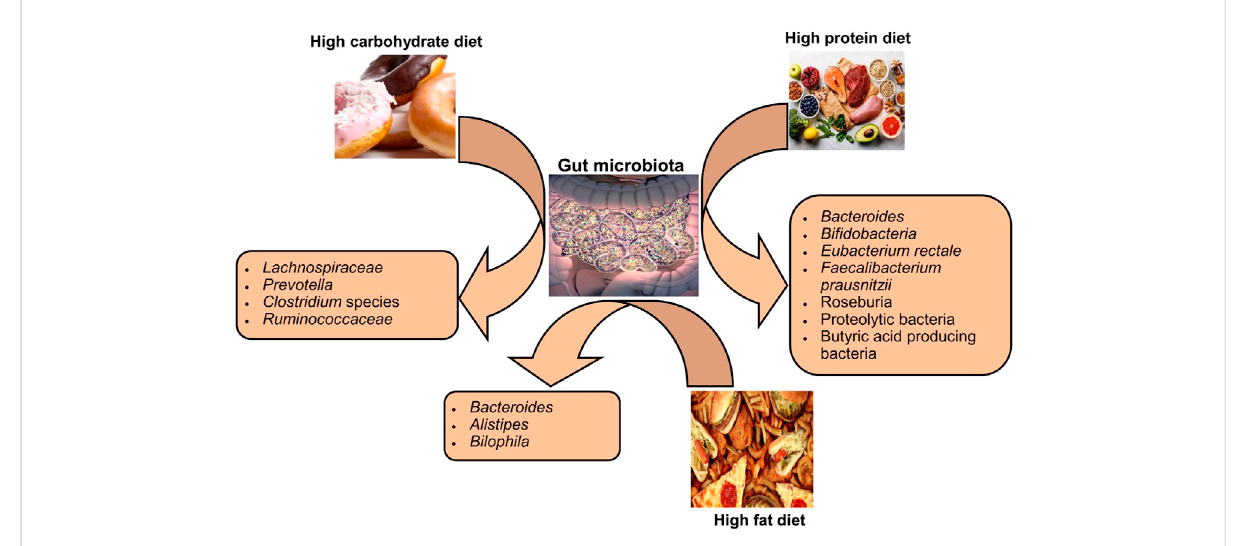
FIGURE 2 Impact of diet types on the composition of gut